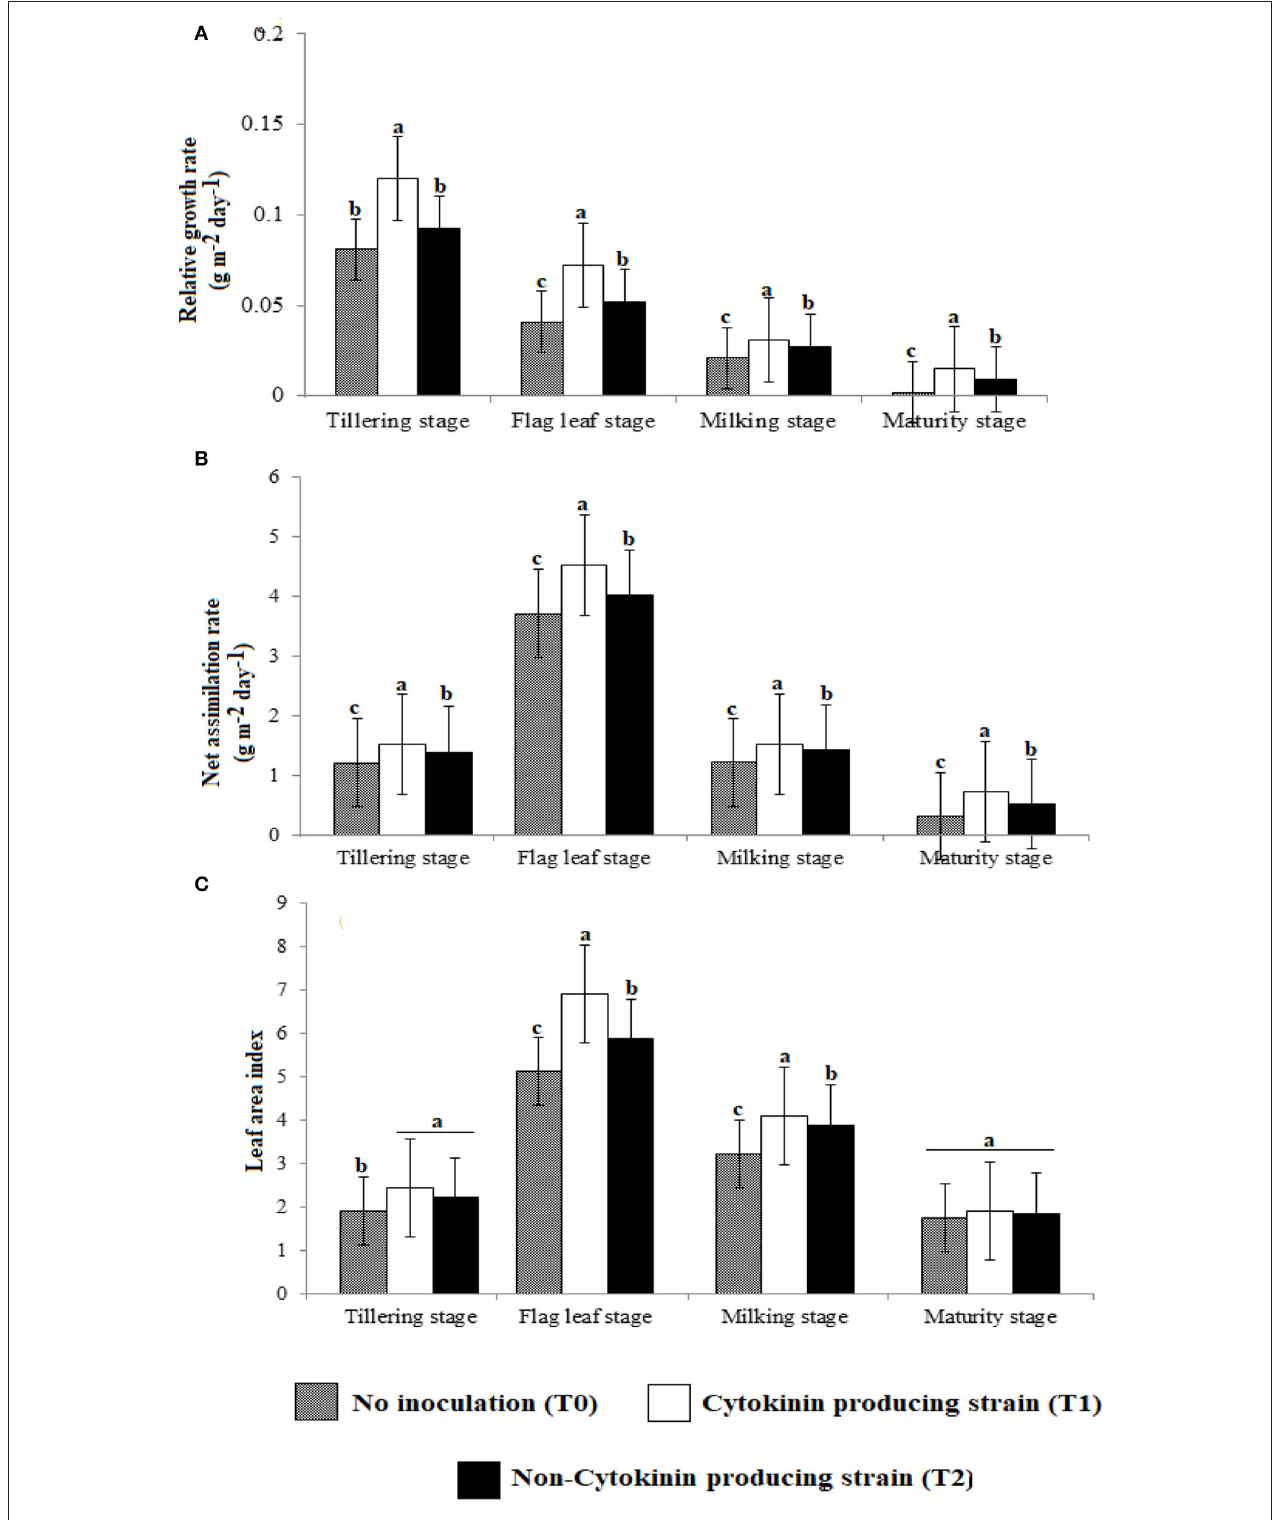
FIGURE 2 | Effect of Ck-producing A. brasilense RA − 17 and non-producing A. brasilense RA − 18 on (A) Relative growth rate (RGR), (B) Net assimilation rate (NAR), and (C) Leaf area index (LAI) of wheat plants. Different letters are significantly other in each column ( p ≤ 0.05), and the different letter shows a significant difference in treatments at a 5% probability